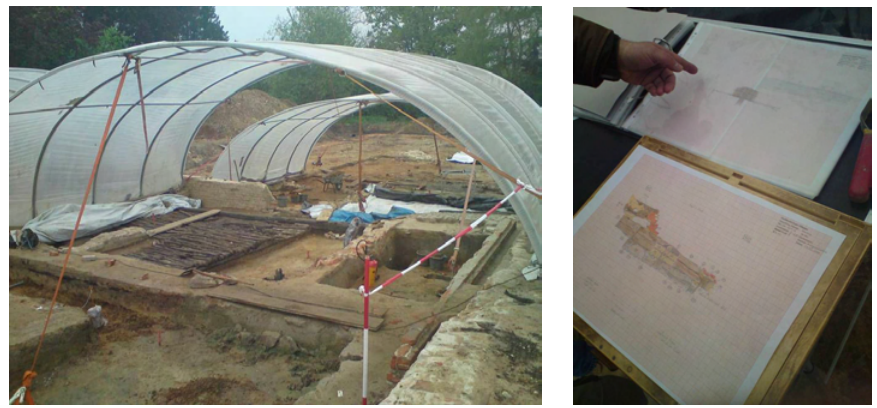
Figure 1: Left: Overview of an excavation site located at “Haus Kump”, a building from the 16th century, which is the oldest storage building in M¨unster, Germany. Right: Findings on a graph paper that were meticulously sketched by an archeologist on